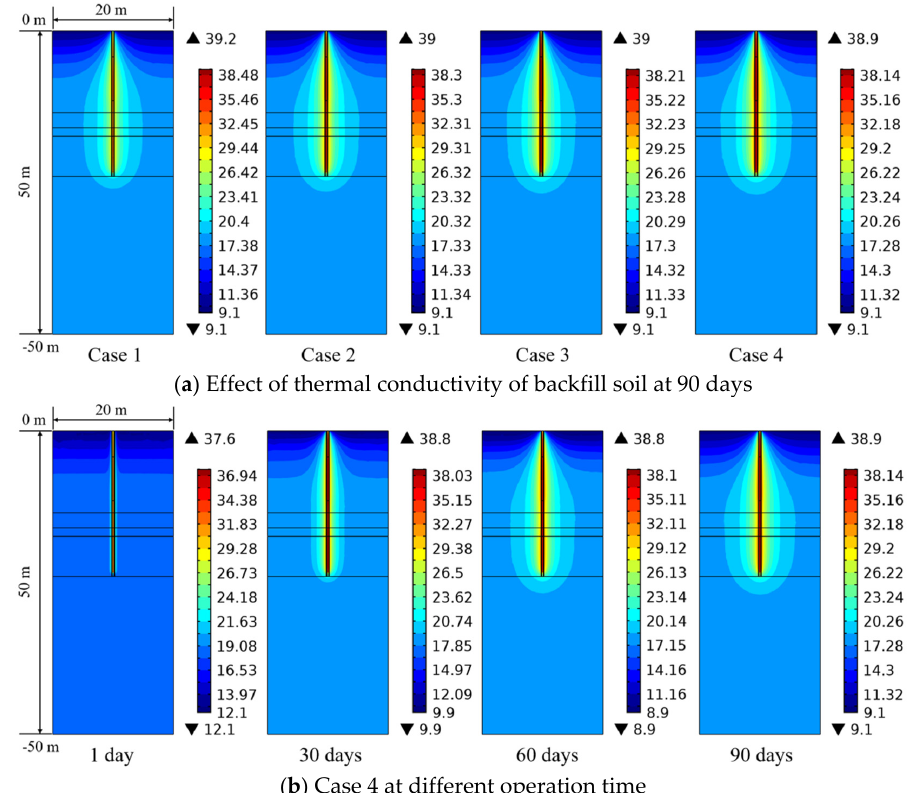
Figure 12. Effect of thermal conductivity of backfill soil in PHC pile and operation time on the ground temperature variation (Units °C).